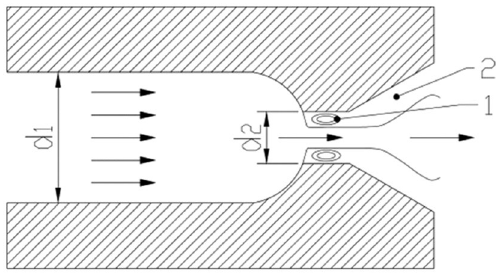
Fig. 4 Mechanism diagram of cavitation jet technology: (1) low-pres- sure tangential region and (2) low-pressure eddy